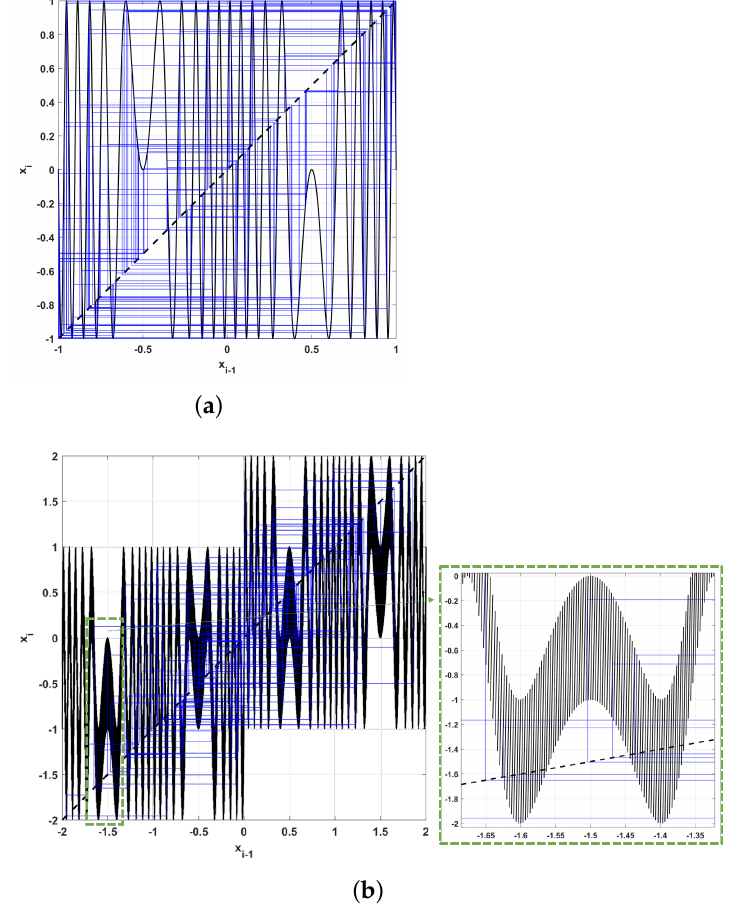
Figure 12. Cobweb diagrams for ( a ) the sine–sine map (26) and ( b ) the modified sine–sine map (27), for k = 10, a = 300, N = 1.